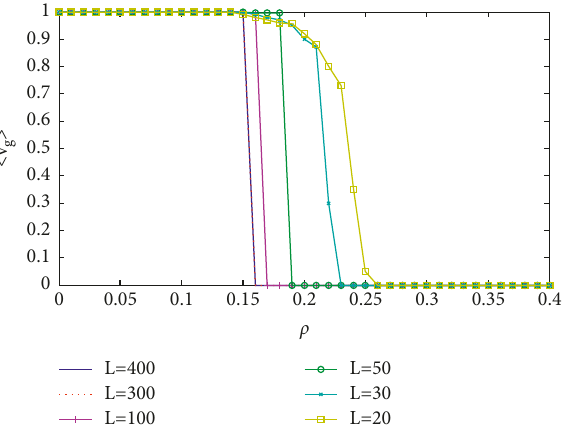
Figure 1: The relationship between average velocity and density of the road network in different